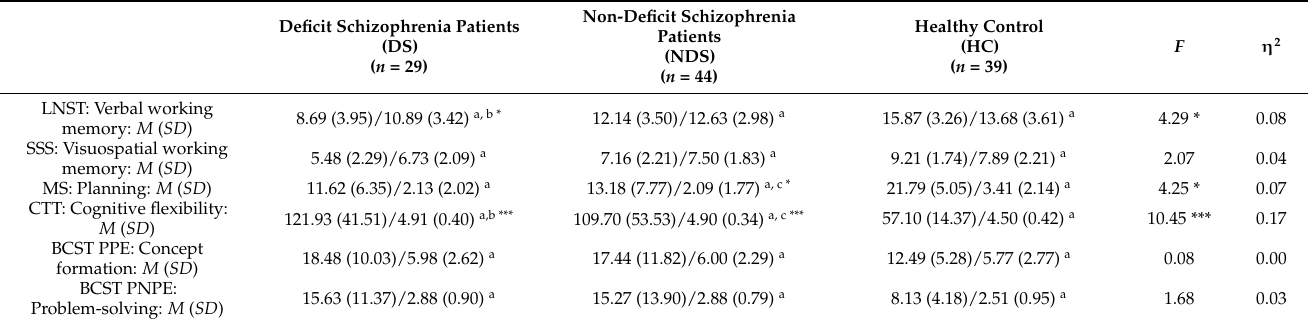
Table 2. Comparison of different aspects of executive functions between all participants, controlling years of education and premorbid IQ.